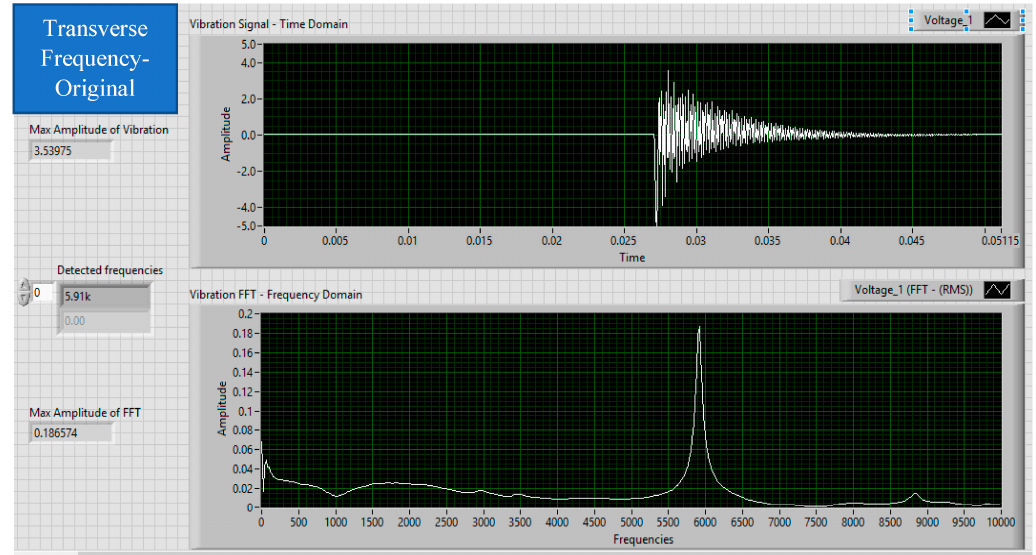
Figure 5. Frequency response of original, cracked and self-healed Polypropylene Fiber Reinforced Concrete (PFRC) samples.